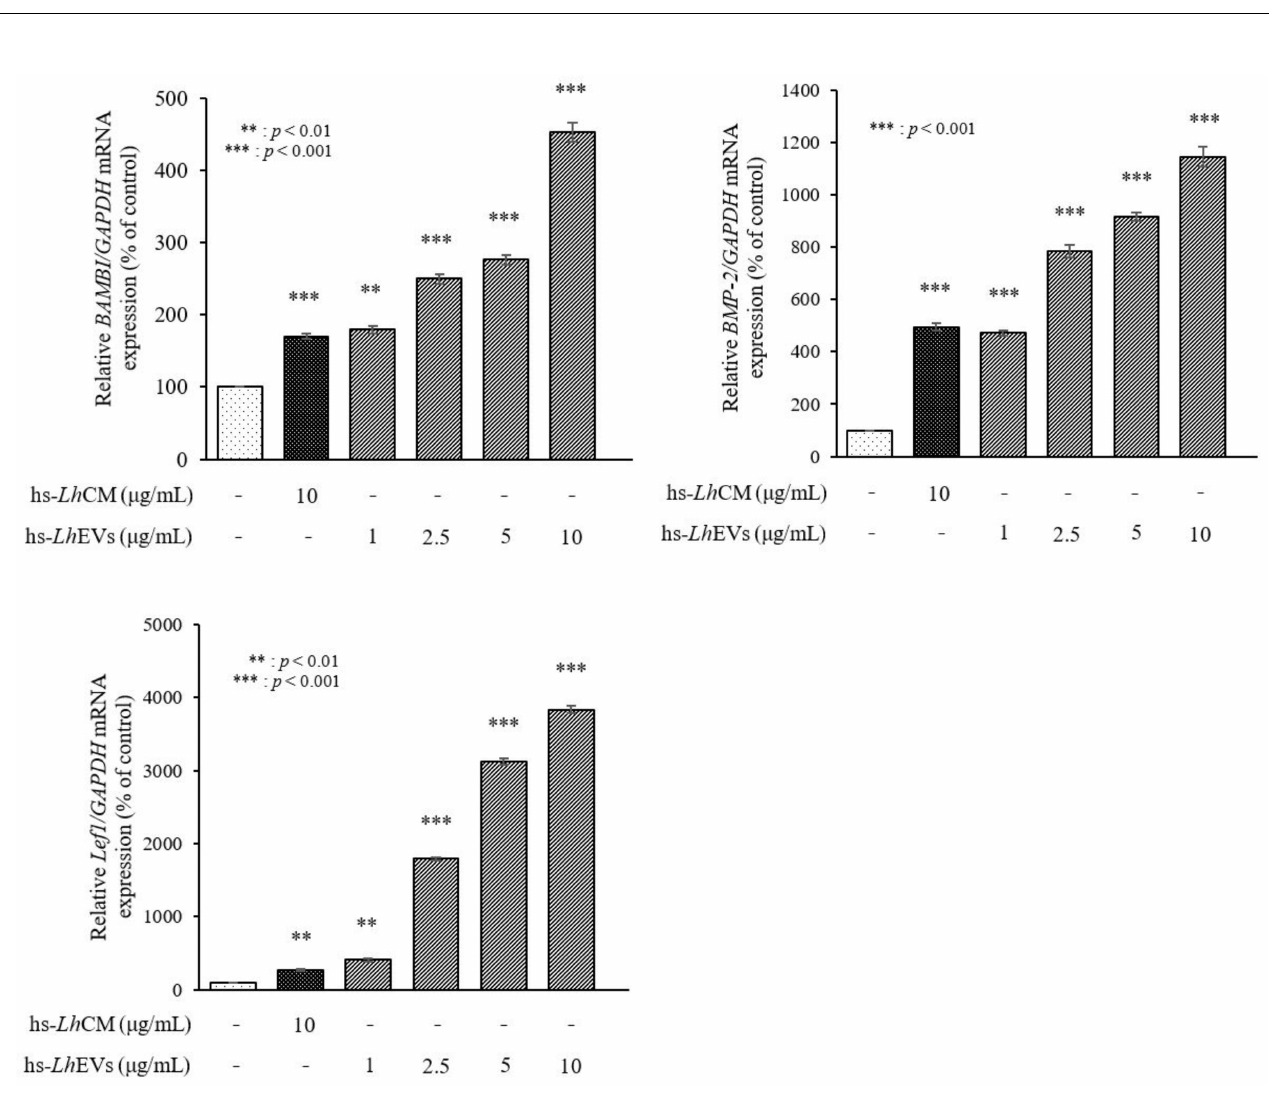
Figure 7. Evaluation of the effects of hs- Lh EVs on Wnt5A , Wnt10B , β - catenin , versican ( VCAN ), BAMBI , BMP - 2 , and Lef1 mRNA expression levels using RT-PCR in HFDPCs. ( A ) The Wnt5A, Wnt10B, β -catenin, BAMBI, Lef1, BMP-2, and versican (VCAN) expression levels in HFDPCs after 24 h of treatment. ( B ) Quantification of mRNA expression shown in ( A ). Data are reported as mean ± SD of three independent experiments. * p < 0.05; ** p < 0.01; *** p < 0.001—Student’s t -test was